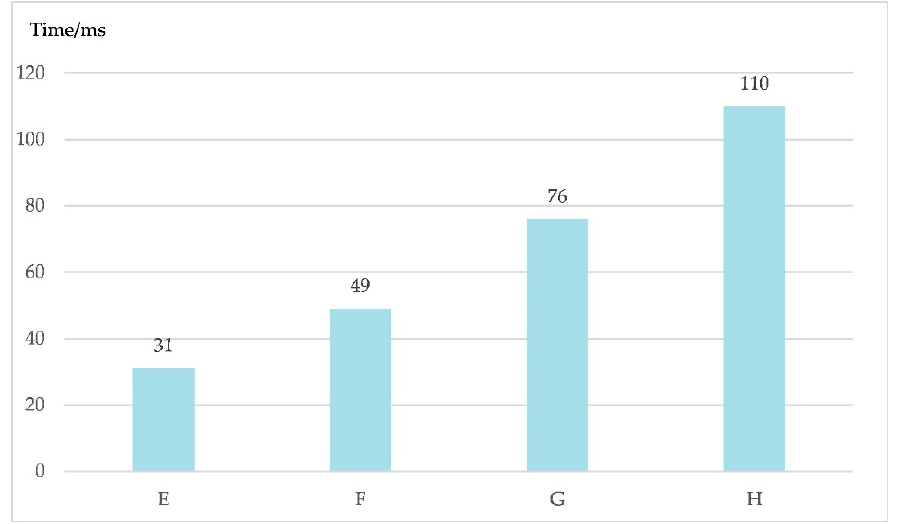
Figure 14. Sensors 2020 , 20 , x